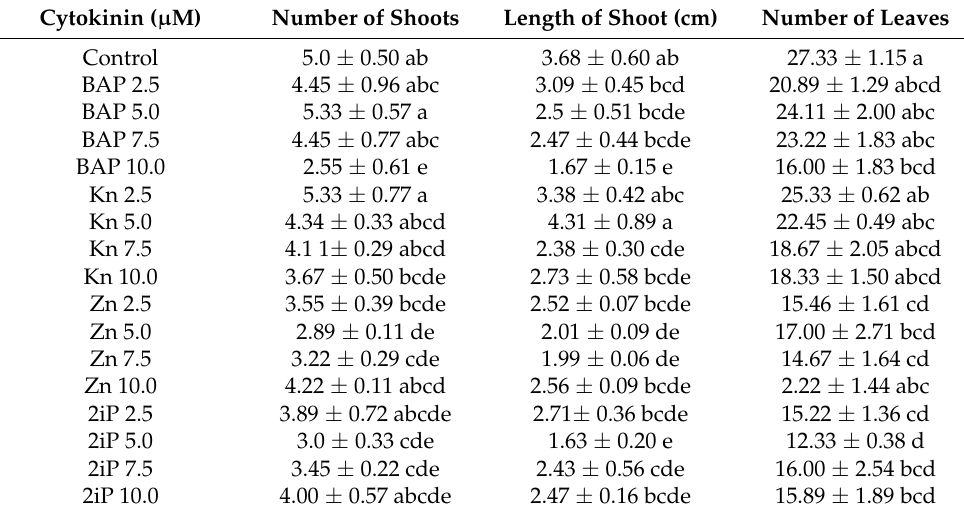
Table 3. Effect of different cytokinin and its concentrations towards the number of shoots, length of the shoot (cm), and number of leaves of P. niruri